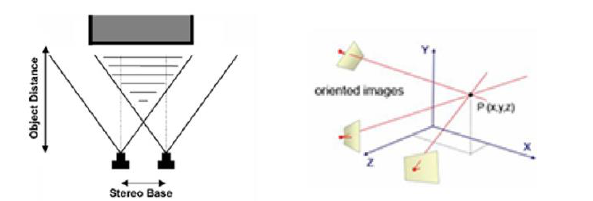
Figure 1. Two methods for obtaining three-dimensional models: stereophotogrammetry with parallel photograps (left) and photogrammetry of multiple images, with convergent photos (right) (Bastian, 2013).